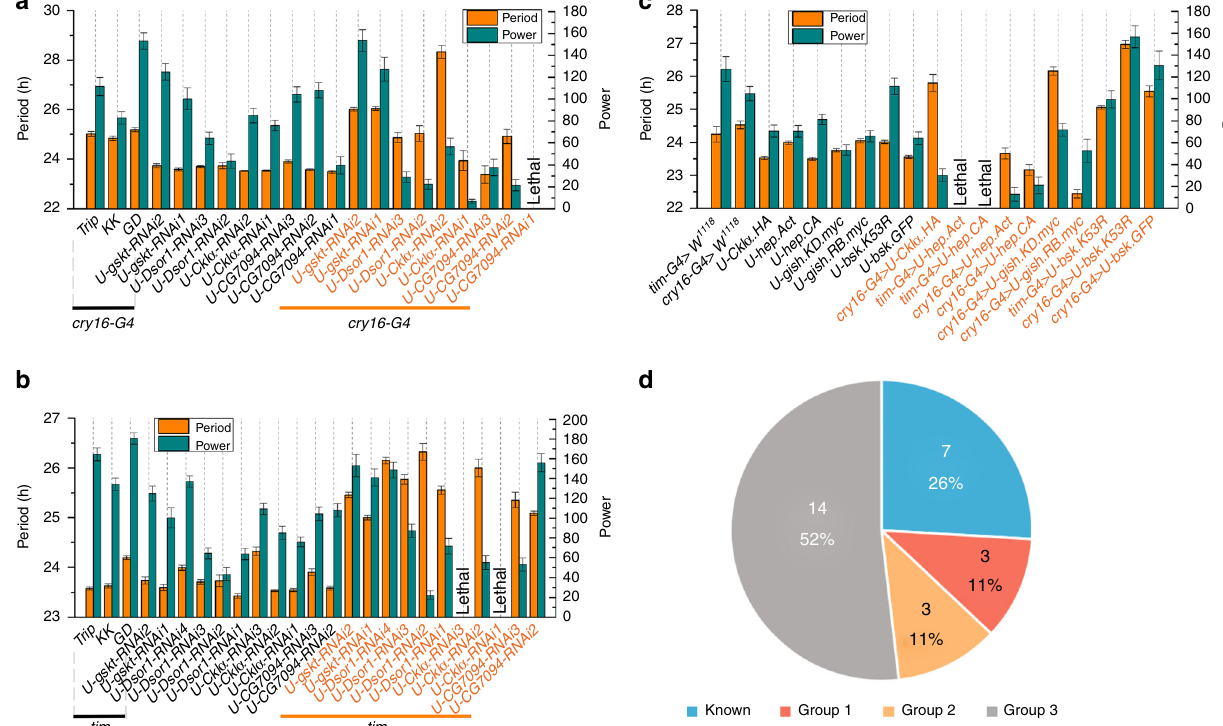
Fig. 5 Identi fi cation of kinases that regulate locomotor rhythm. a Period and power of DD locomotor rhythms of fl ies with gskt , Dsor1 , CK1 α , and CG7094 knocked down using cry-GAL4-16 , along with the controls. dicer2 ( dcr2 ) is co-expressed to enhance the effects of RNAi (From left to right, n = 43, 74, 50, 27, 26, 48, 42, 61, 72, 43, 45, 20, 37, 36, 36, 43, 45, 53, 22, and 42). b Period and power of DD locomotor rhythms of fl ies with gskt , Dsor1 , CK1 α , and CG7094 knocked down using tim GAL4, along with the controls (From left to right, n = 52, 61, 74, 27, 26, 47, 48, 42, 47, 59, 61, 72, 43, 45, 37, 26, 44, 45, 30, 30, 25, 38, and 45). c Period and power of DD locomotor rhythms of fl ies overexpressing WT or mutant forms of hep , bsk , CK1 α , and gish , along with the controls (From left to right, n = 28, 44, 30, 60, 29, 43, 41, 30, and 31). All of the experimental groups show signi fi cant difference compared with the corresponding controls. Error bars represent SEM. One-way ANOVA, individual p values are shown in Supplementary Data 7. G4, GAL4; U, UAS. d Percentage of predicted circadian kinases that are previously known to regulate the clock (blue), identi fi ed here to be involved (red) or potentially involved (orange) in circadian regulation, or not yet validated